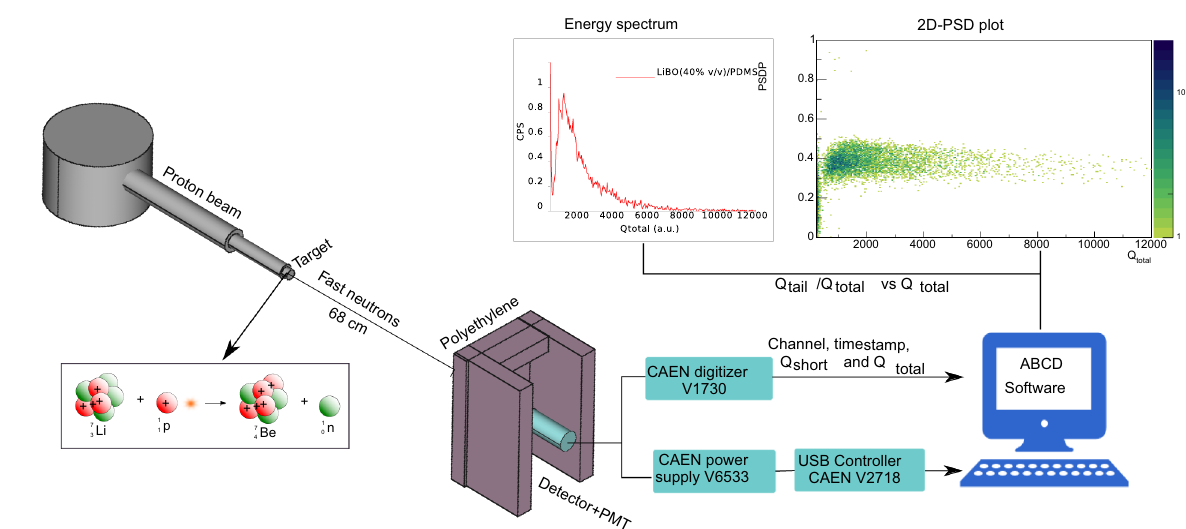
Figure 11. Schematic view of the experimental setup at the CN